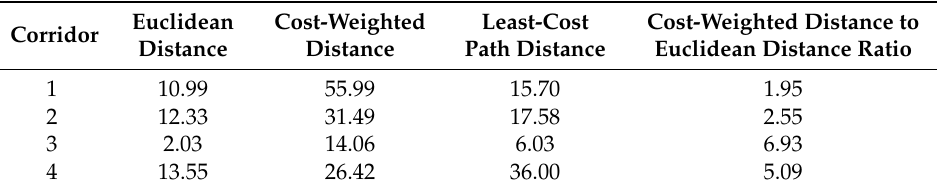
Table 3. Mato Grosso do Sul habitat connectivity analysis